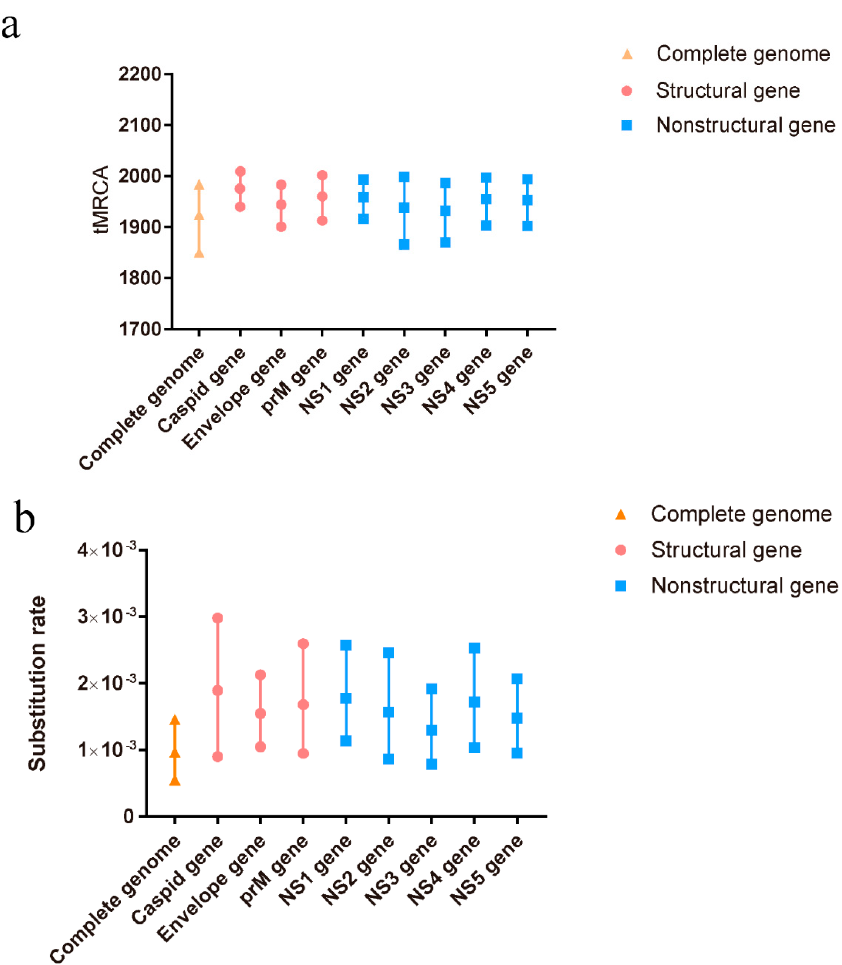
Figure 1. The tMRCAs and substitution rates were evaluated in BEAST (v1.10.4) for the complete genome and individual genes of TMUV. ( a ) The tMRCA of TMUV. ( b ) The substitution rate of TMUV. Yellow triangles represent the complete genome, red circles represent structural genes, and blue squares represent non-structural genes.